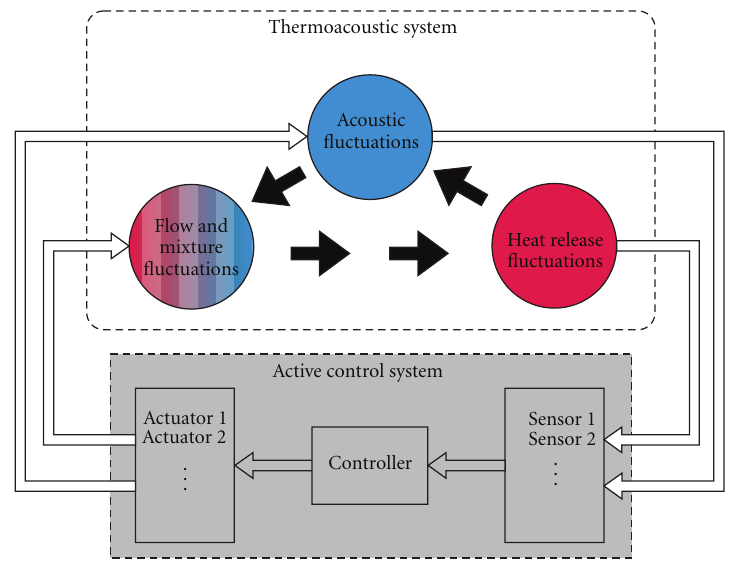
Figure 1: Active control of thermoacoustic instabilities (in parts taken from